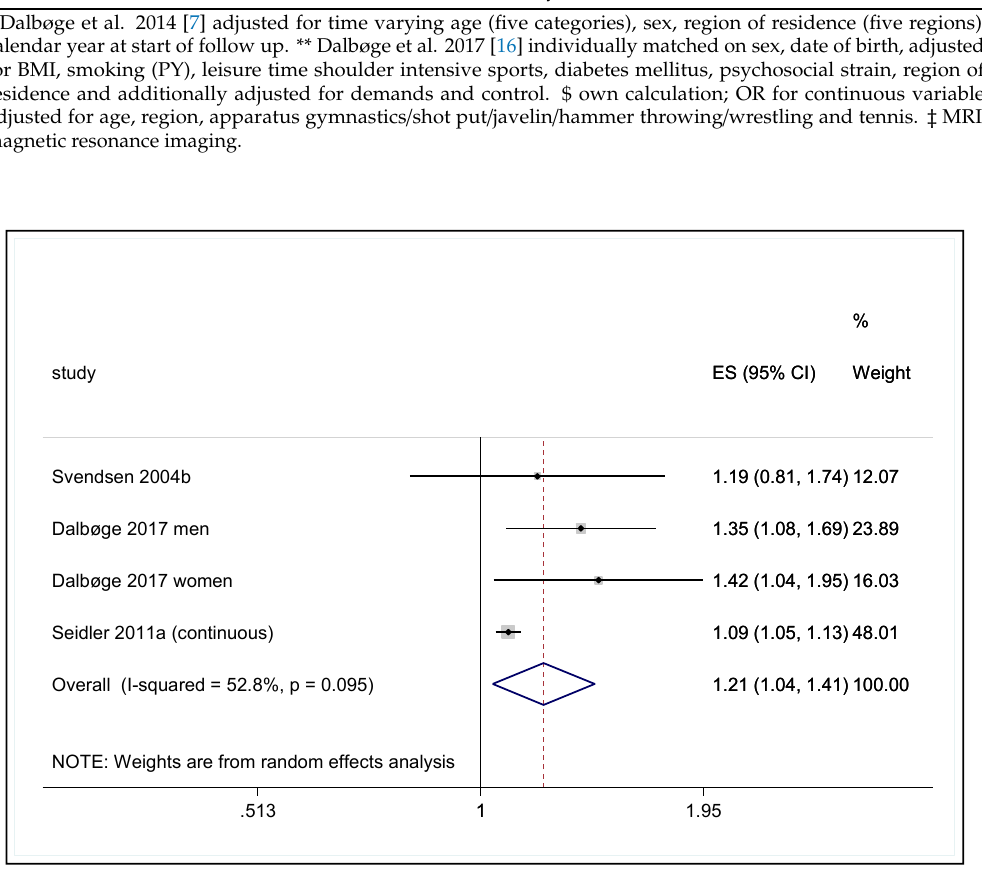
Figure 2. Forest plot of specific shoulder disease risk due to above-shoulder level work.